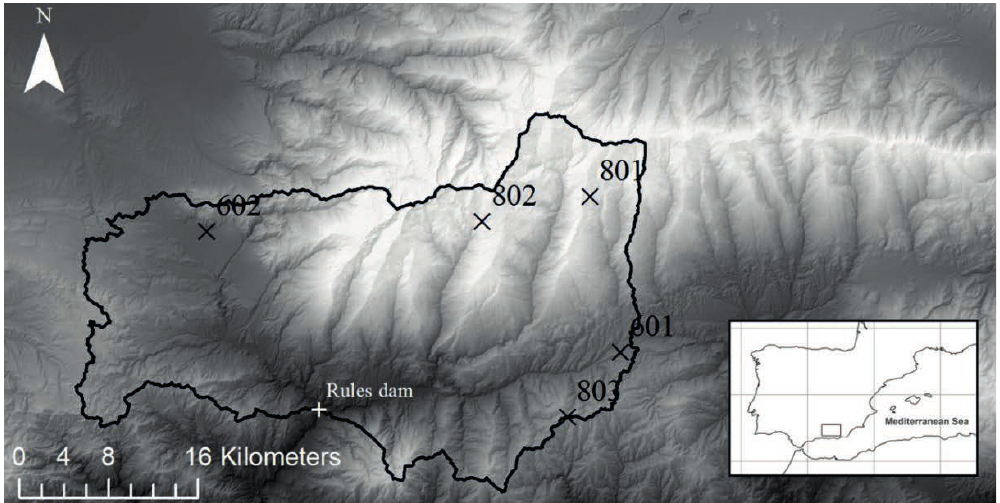
Fig. 1 Location of Sierra Nevada Mountain Range in Spain, limits of the study area (black line), Rules Dam (white cross) and weather stations employed in the study (black